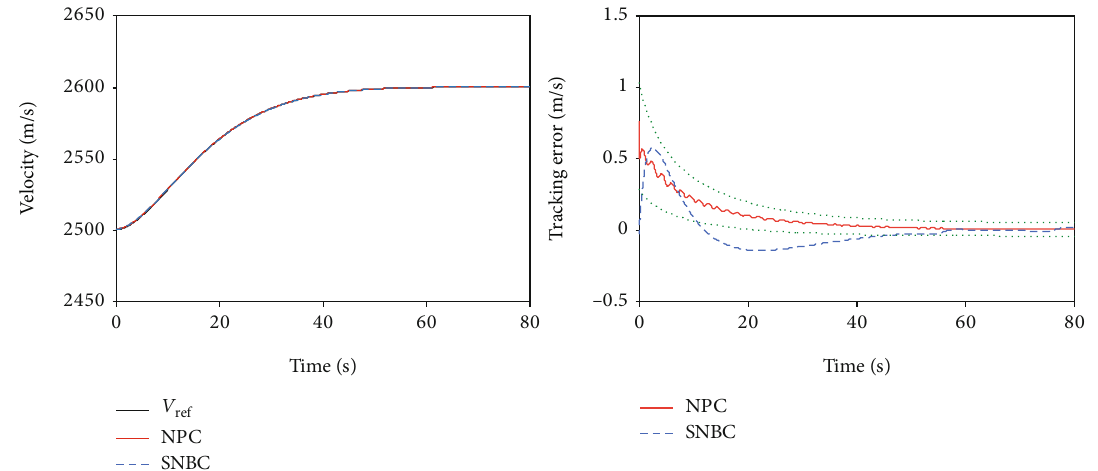
Figure 4: Velocity tracking performance of the